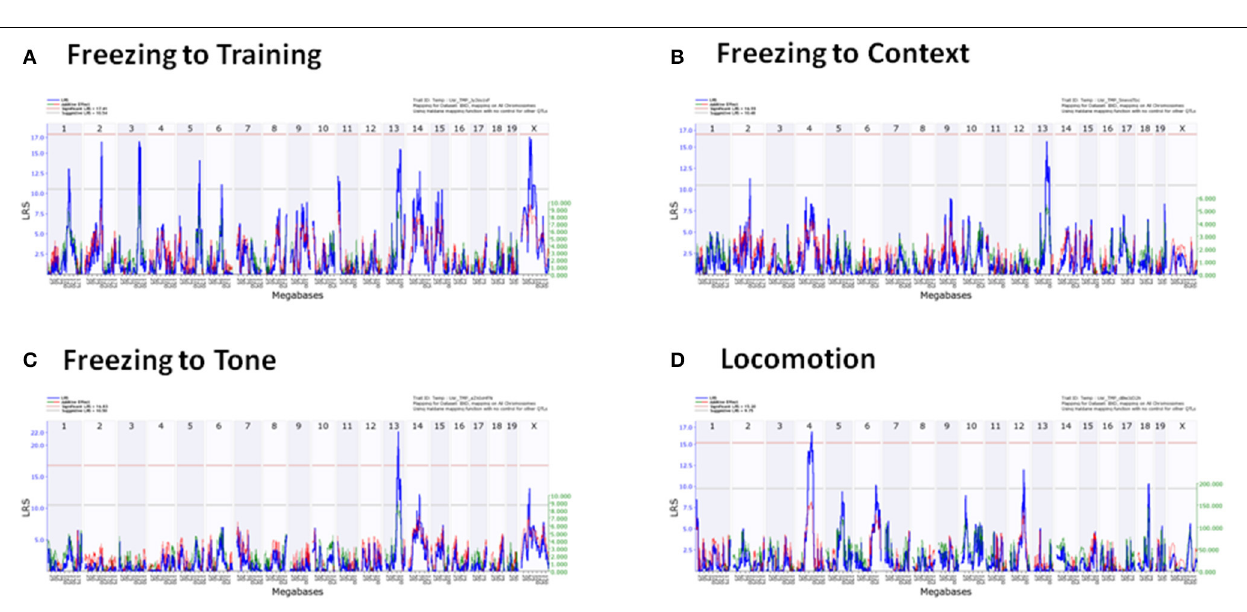
FIGURE 6 | Individual QTL maps of chronic stress population phenotypic traits. (A) Freezing to Training (Day 1), (B) Freezing to Context (Day 2), (C) Freezing to Tone (Day 3), (D)